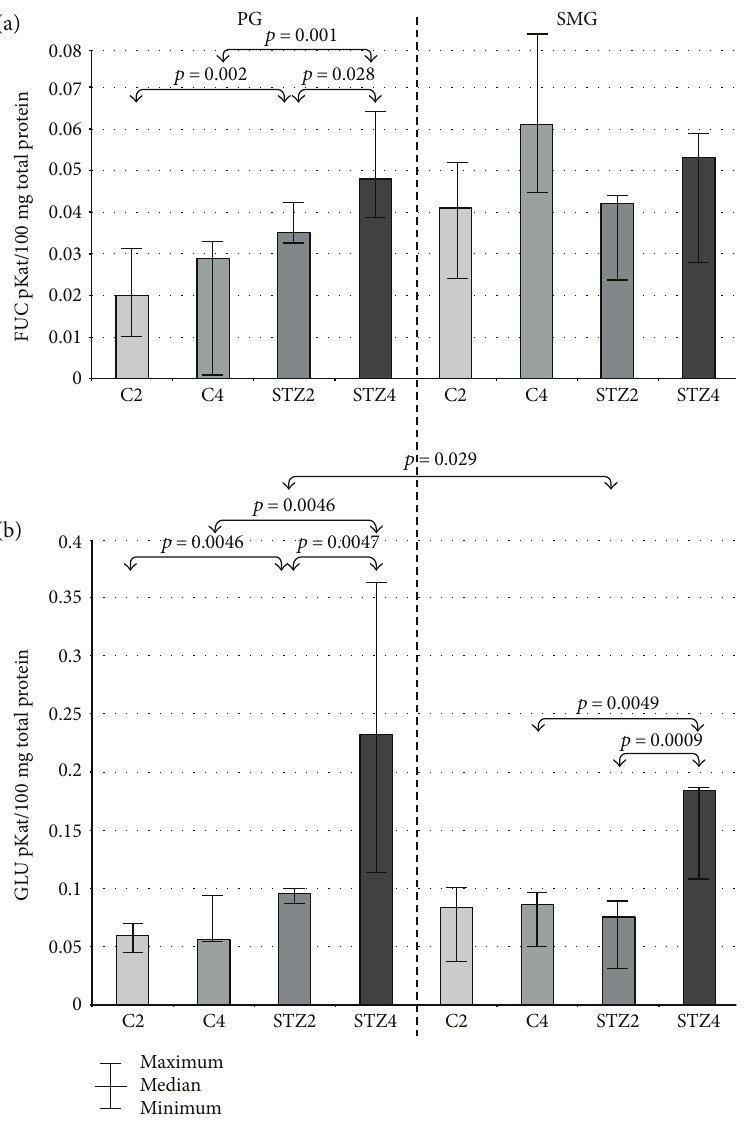
Figure 3: The e ff ect of STZ-induced diabetes on activity of FUC and GLU in the parotid and submandibular glands of rats. C2 and C4 are the control groups; FUC: α -fucosidase (FUC); GLU: β -glucuronidase; PG: parotid glands; SMG: submandibular glands; STZ2 and STZ4: diabetic